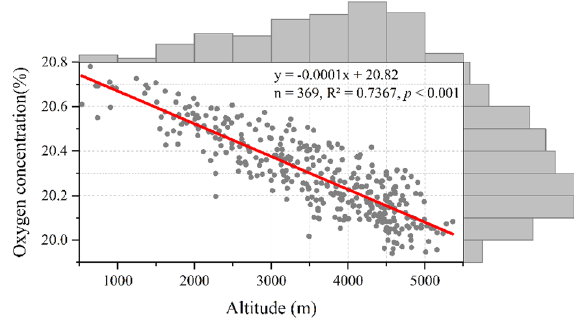
Figure 4. Decreasing oxygen concentration as a function of altitude (winter samples excluded) 16 . The red line indicates the linearly fitted trend of oxygen concentration. The upper and right histograms depict the frequency distribution of altitude and oxygen concentration, respectively.